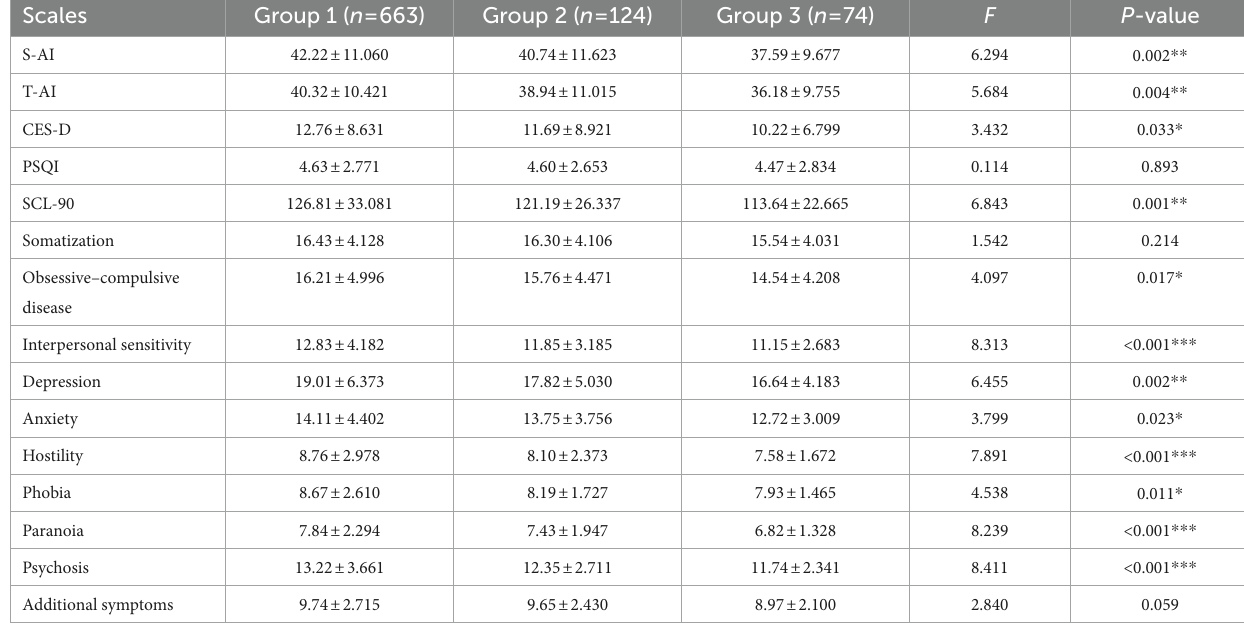
TABLE 2 Comparison of levels of anxiety, depression and psychiatric symptoms between recurrent pregnancy loss (RPL) women and non-RPL women.